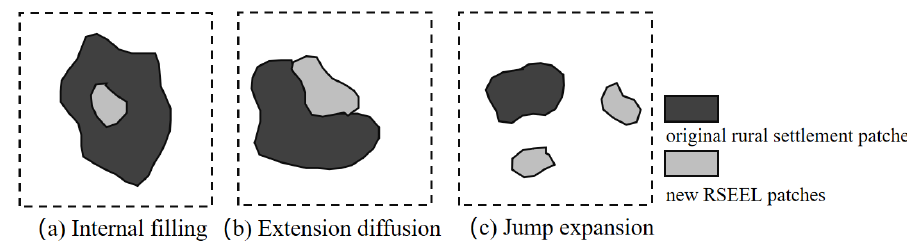
types (Figure 3): internal filling (50 < LEI i ≤ 100), extension diffusion (0 < LEI i ≤ 50), and jump expansion ( LEI i = 0).